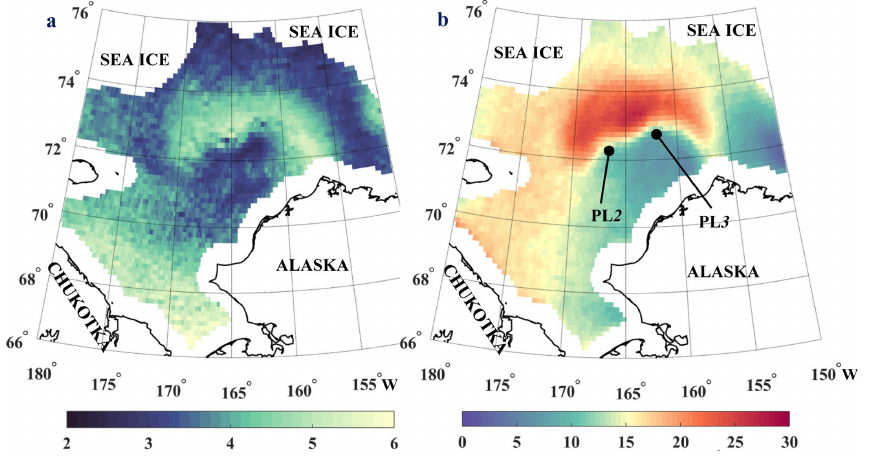
Figure 5. PL pair in the fields of ( a ) atmospheric total water vapor content (kg/m 2 ) and ( b ) near- surface wind speed (m/s) retrieved from the AMSR2 measurements at 14:25 UTC on 19 October 2017. Black dots on ( b ) indicate the PL 2 and PL 3